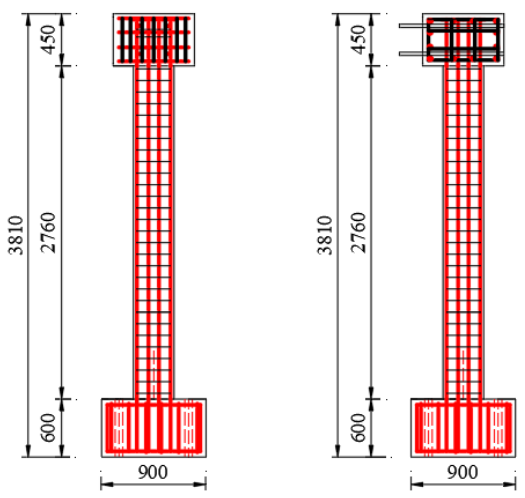
Figure 6. Construction drawing of the central column specimen (units: mm). Note: left figure view is from loading direction, right figure view is perpendicular to loading direction.